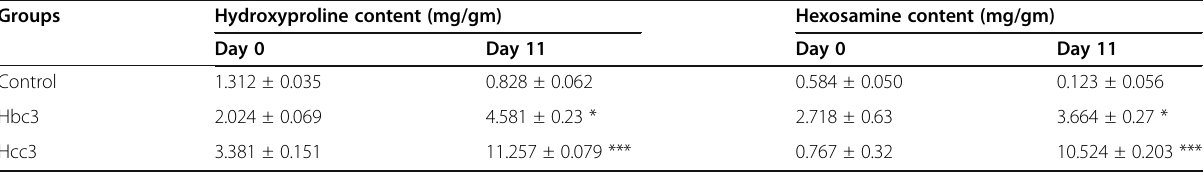
Table 4 Effect of bioscaffolds on hydroxyproline and hexosamine contents in animals Groups